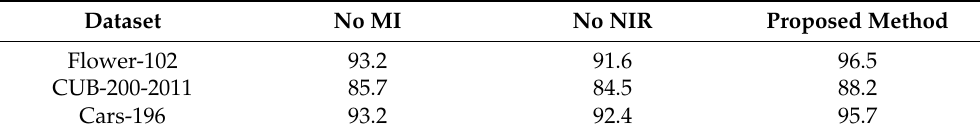
Table 5. Influences of misclassification information and new image representations on the Flower-102 dataset, CUB-200-2011 dataset, and Cars-196 dataset. no MI—without misclassification information (a simple combination of prelearned models with averaged predictions); no NIR—without new image representation (using the predicted classes over all the selected subsets corresponding to the pretrained models for